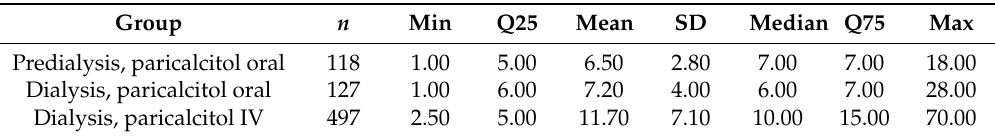
Table 9. Weekly dose (mcg) of paricalcitol: statistical characteristics at study start.